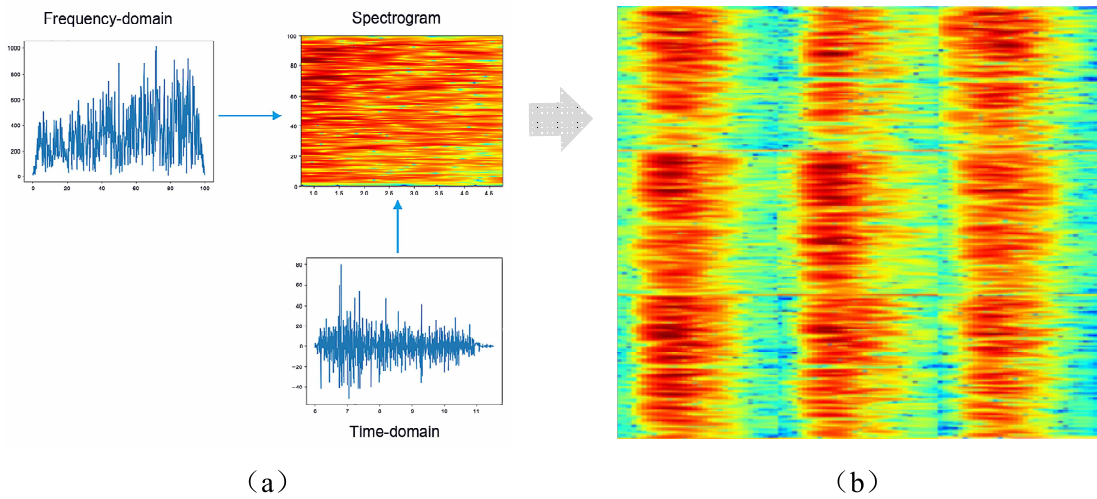
Figure 8. ( a ) Combine the time-domain figure and the frequency-domain figure into a spectrogram. ( b ) Spectrogram of the combined layers.